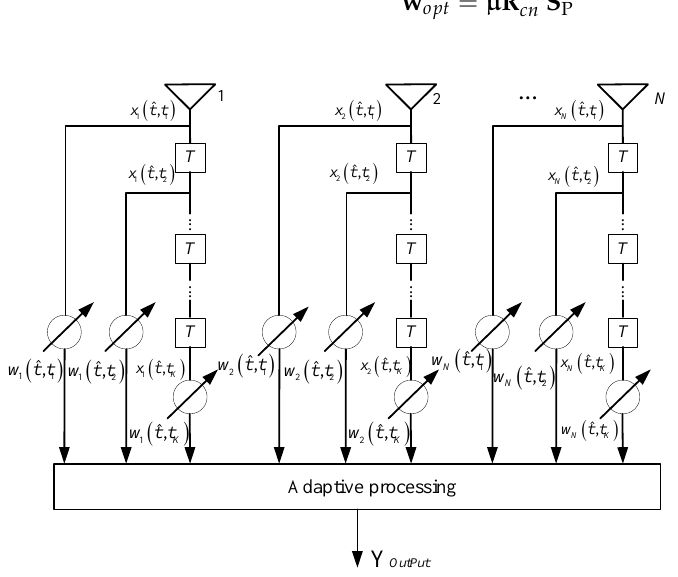
Figure 2. Structure diagram of Space-time Adaptive Processing (STAP). Corresponding to Figure 2, the other expression of the w opt